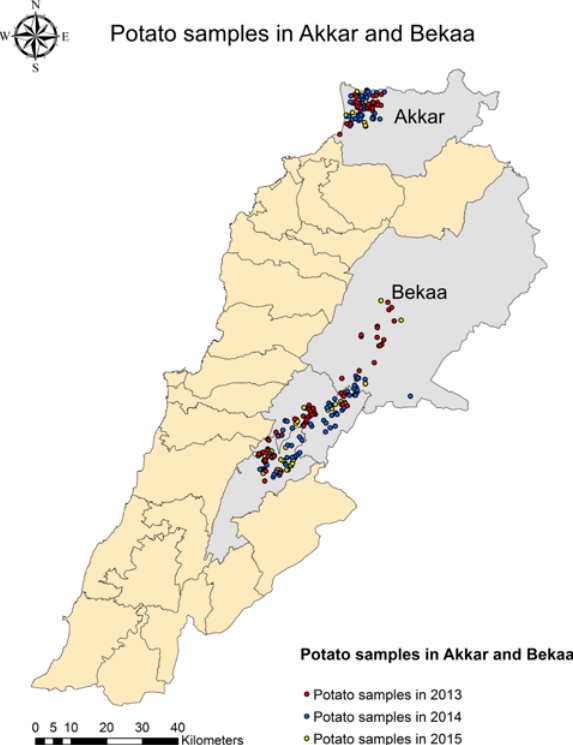
Figure 2. Water sampling sites in the Akkar district and the Bekaa valley in Lebanon during three growing